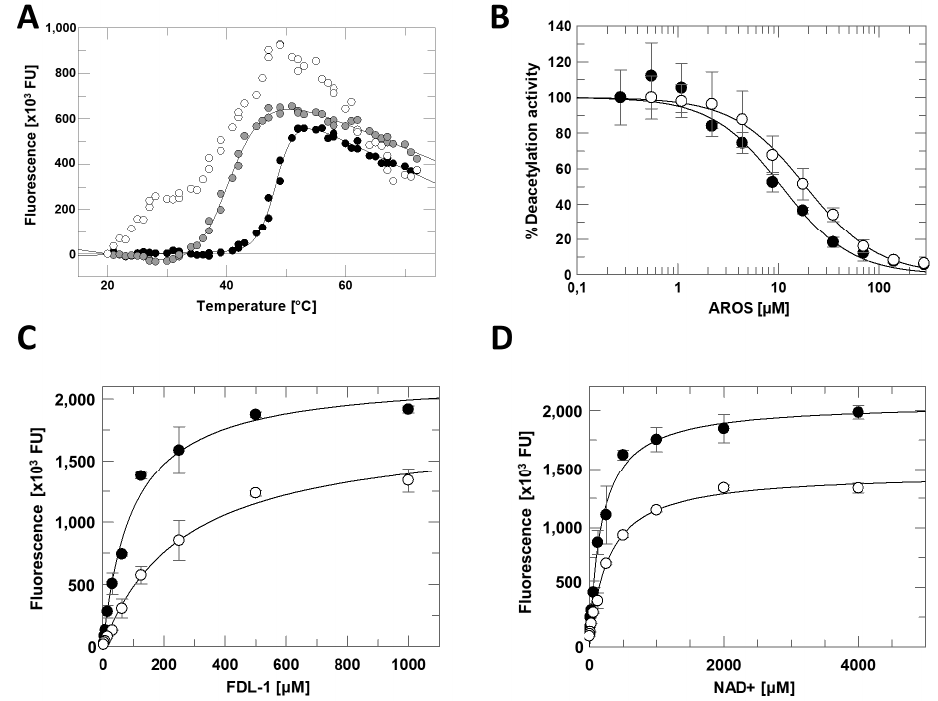
Figure 3. Sirt1 inhibition by AROS. ( A ) Thermal denaturation of the Sirt1/AROS complex in 20 mM Tris/HCl pH 7.0; 120 mM NaCl; 0.08% Tween 20 (white), or in 50 mM Tris/HCl pH 7.5 (grey), or in 50 mM Na 2 HPO 4 /NaH 2 PO 4 pH 7.0 (black). ( B ) Dose-dependent inhibition of fl-Sirt1 (black) and mini-Sirt1 (white) by AROS in the FdL deacetylation assay. ( n = 3; error bars: SD) ( C ) Substrate peptide titrations of Sirt1 in FdL activity assays in presence (white) and absence (black) of 40 µM AROS. ( n = 3; error bars: SD) ( D ) NAD + titrations of Sirt1 in FdL activity assays in presence (white) and absence (black) of 40 µM AROS. ( n = 3; error bars: SD).